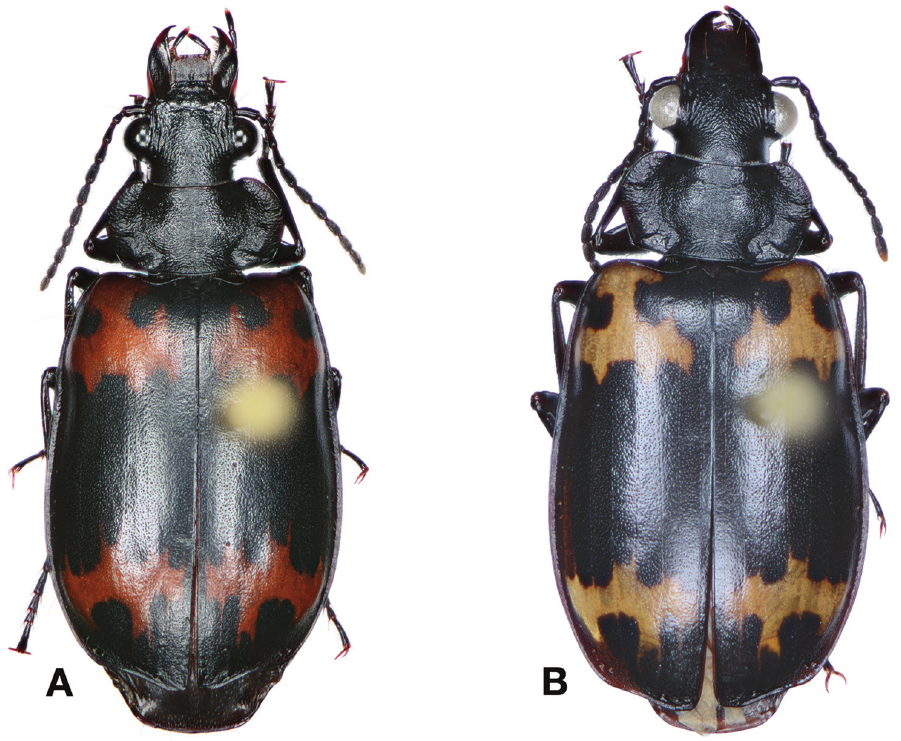
Figure 86. Dorsal habitus and intrapopulation variation of color pattern of Lioptera erotyloides Bates. A red elytral macula (OBL 15.20 mm) B orange elytral macula (OBL 11.92 mm). rather dentate, from interval 2, to just before outer margin, reaching basal border of elytra in interval 4 to 7, posterior macula more narrow laterally but also and rather